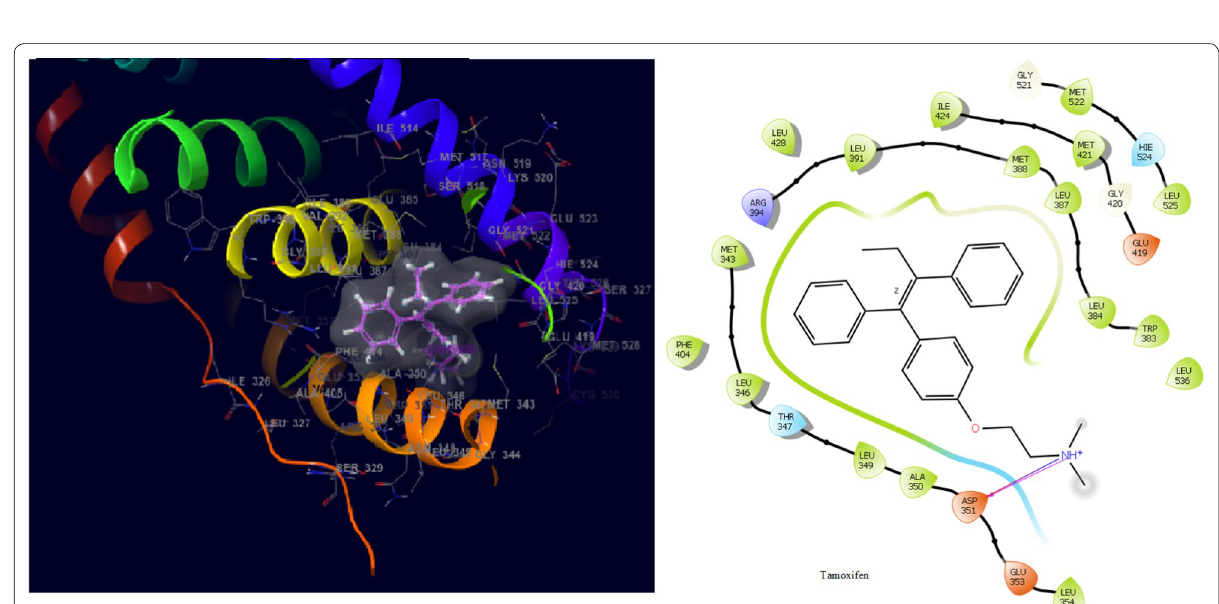
Fig. 9 Interaction of tamoxifen within the active pocket of 3ERT protein and interacting amino acid in 2D view